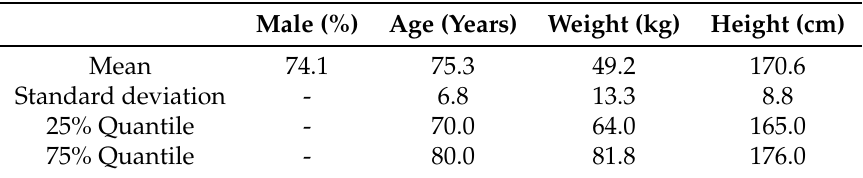
Table 1. Descriptive statistics of the